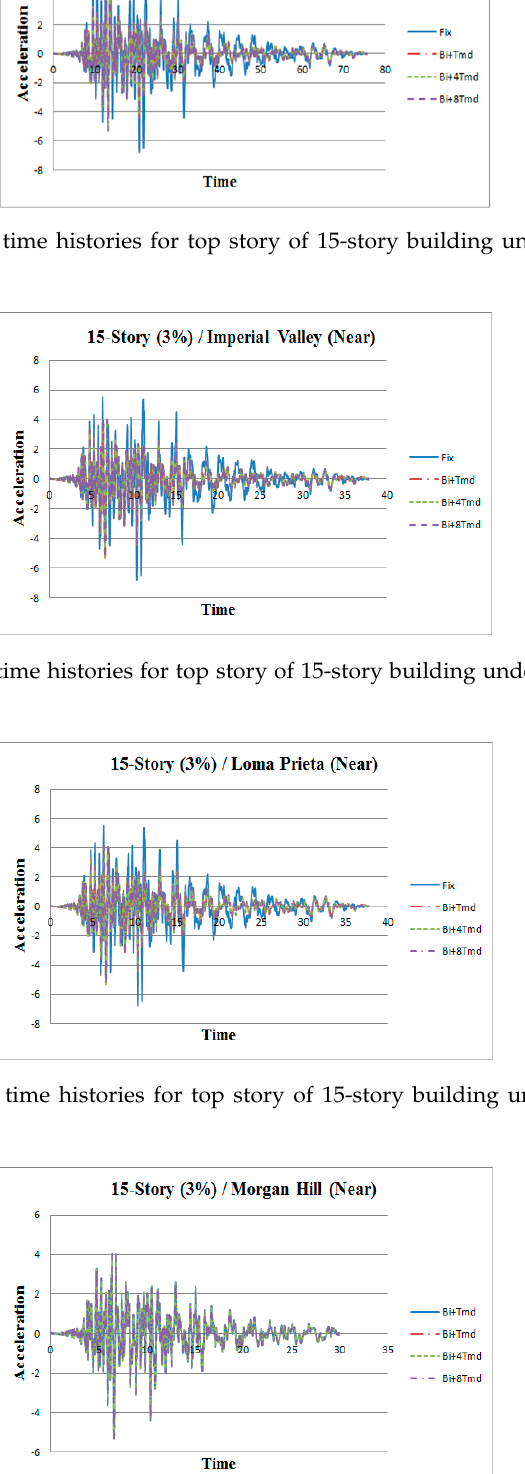
Figure A6. Acceleration time histories for top story of 15-story building under the Morgan Hill (near-fault) earthquake.